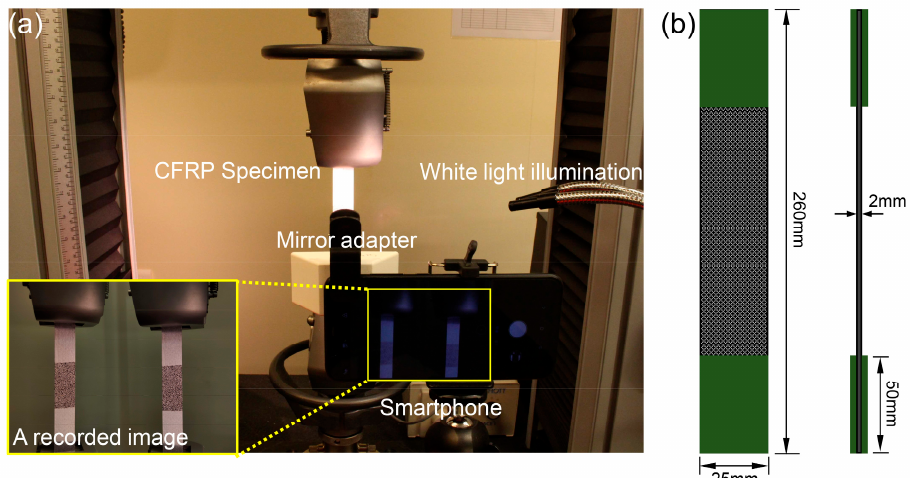
Figure 11. ( a ) Experimental set-up used to examine the mechanical properties of the carbon fiber-reinforced plastics (CFRP) specimens, with a captured image using the established imaging system shown in the insert image. ( b ) Schematic diagram of the CFRP specimen.